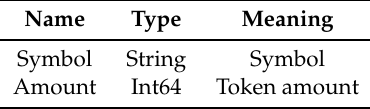
Table 5. Data structure of